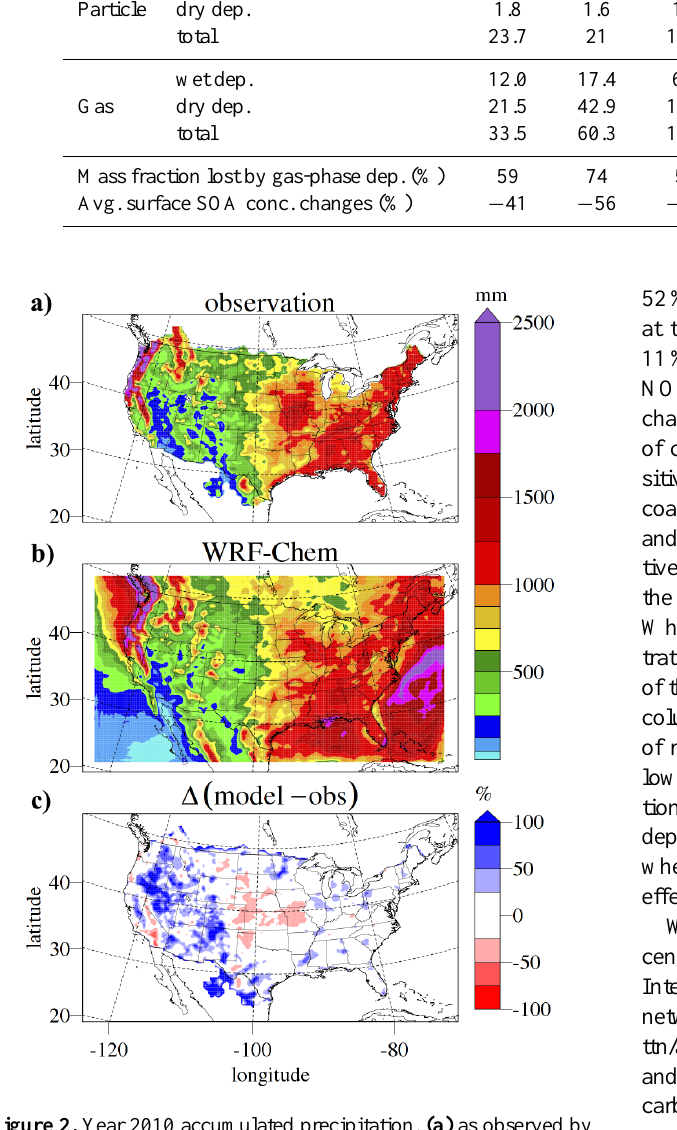
Figure 2. Year 2010 accumulated precipitation. (a) as observed by rain gauge/radar network. (b) WRF-Chem model results. (c) differ- ences relative to observations ( (cid:49)( model − obs ) = ( mod − obs )/ obs ×